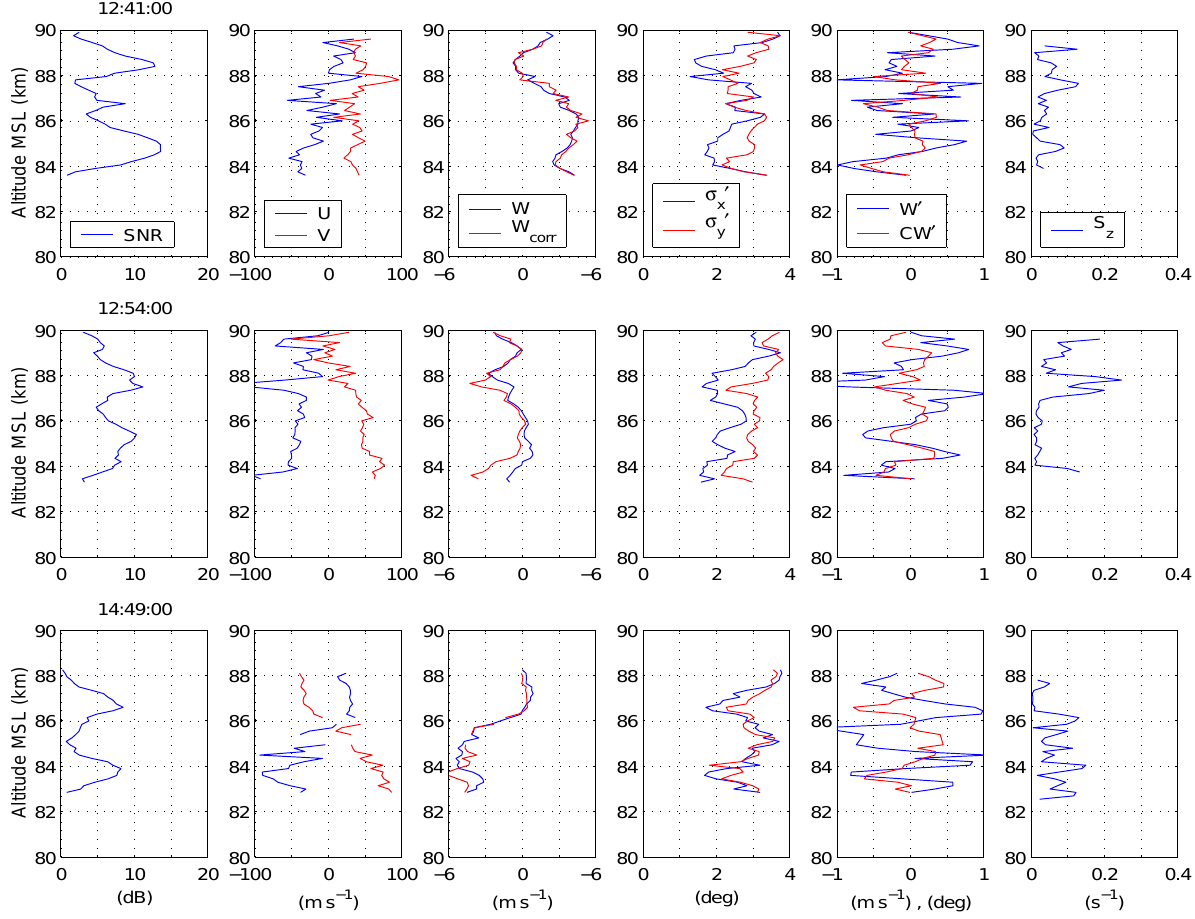
Fig. 5. Height profiles of various observables related to SNR, aspect sensitivity, and wave activity during the PMSE event for three selected time intervals. The four right most panels show estimates of the signal-to-noise ratio (SNR); zonal (U) and meridional (V) components of the horizontal wind; the vertical velocity (W); and the half-widths of the brightness distribution ( σ 0 x and σ 0 y ). Height profiles of the high-pass filtered values of the vertical wind ( W 0 ) and the high-pass filtered values of the characteristic width of the brightness distribution ( CW 0 ) are given in the next column of panels. Estimates of the vertical shear in the horizontal wind ( S z ) are shown in the right most